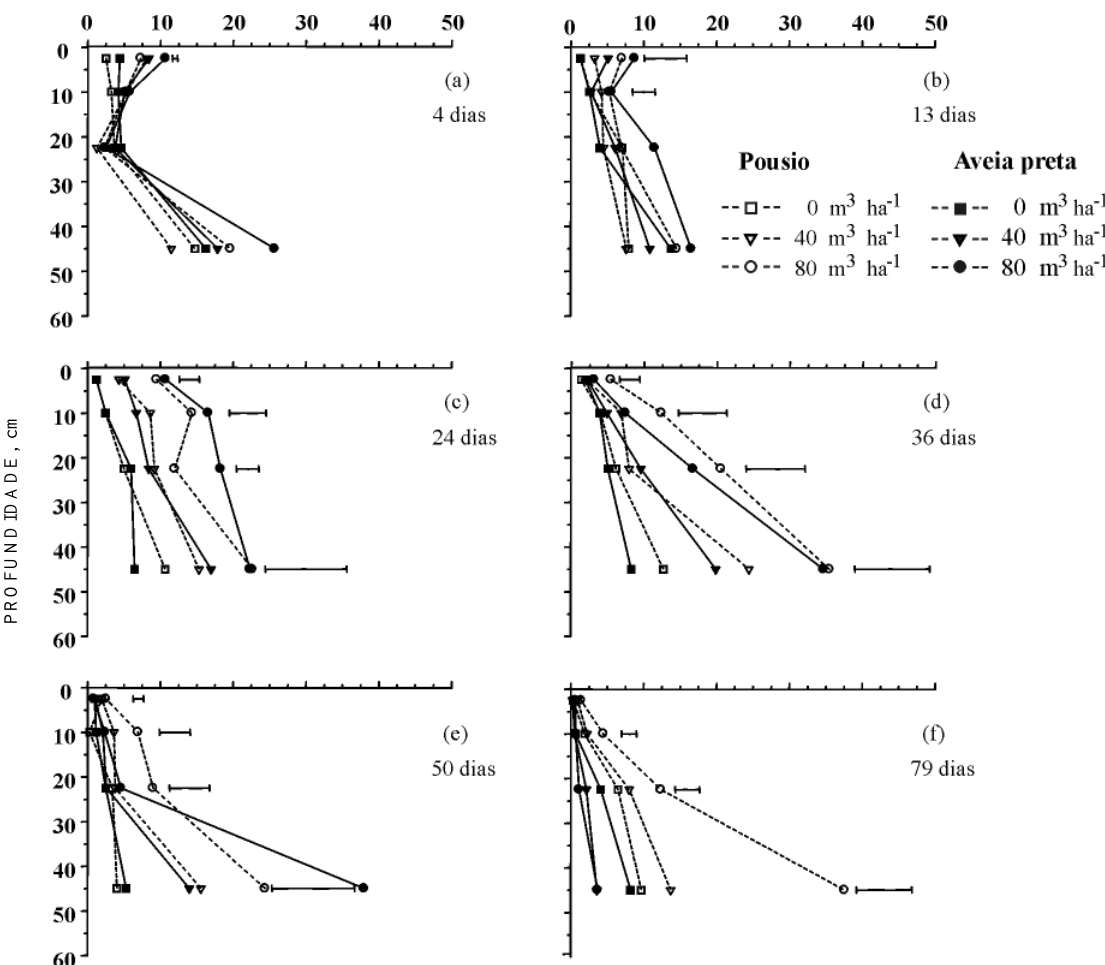
Figura 1. Quantidades de N-NO 3- na camada de 0-60 cm do solo durante o desenvolvimento da aveia e da vegetação espontânea (pousio), aos 4, 13, 24, 36, 50 e 79 dias da aplicação dos dejetos (0, 40 e 80 m 3 ha -1 ). Barras horizontais indicam diferença mínima significativa (Tukey a 5